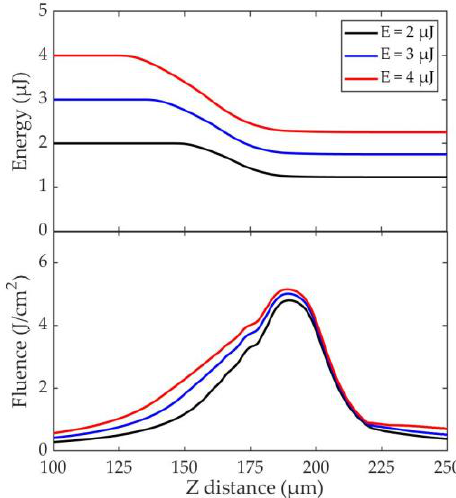
Figure 3. Energy and fluence evolution along the beam propagation direction in Nd:YAG.